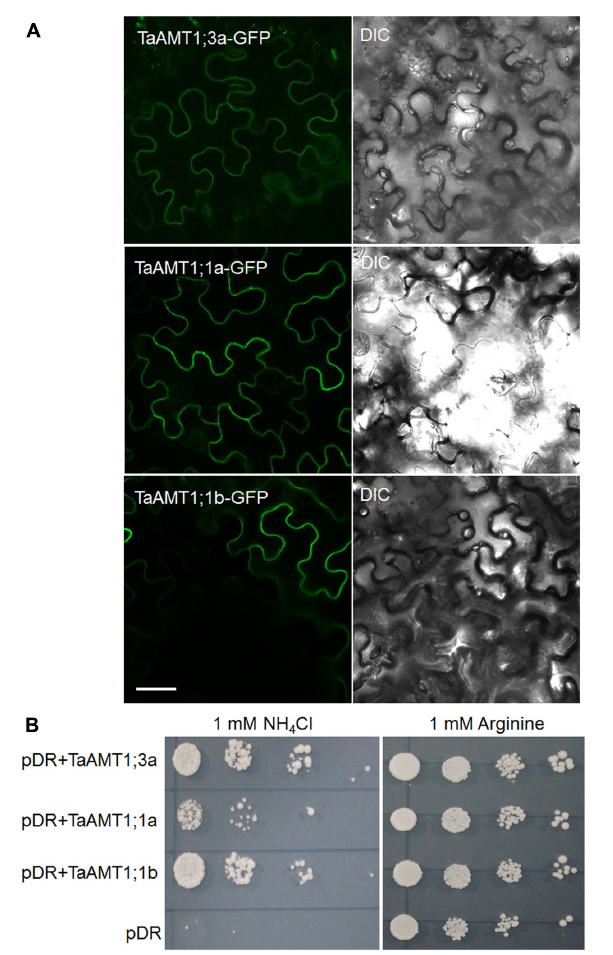
FIGURE 3 | Localization and functional analysis of TaAMT1;1a, TaAMT1;1b, and TaAMT1;3a proteins. Agrobacterium -mediated transient expression of TaAMT1;1a, TaAMT1;1b, and TaAMT1;3a-GFP constructs in N. benthamiana leaves. GFP fluorescence and bright field images are shown in the left and right panels, respectively. Bar = 20 µ m (A) . The functions of TaAMT1;1a, TaAMT1;1b, and TaAMT1;3a genes were analyzed by complementation of